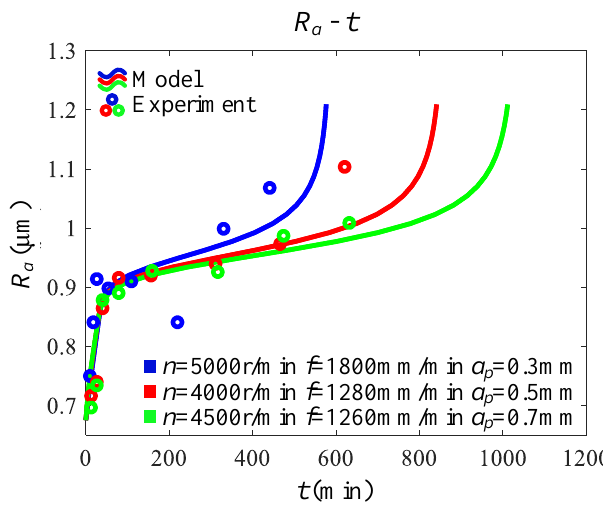
Figure 13. Value comparison of experimental and model data.